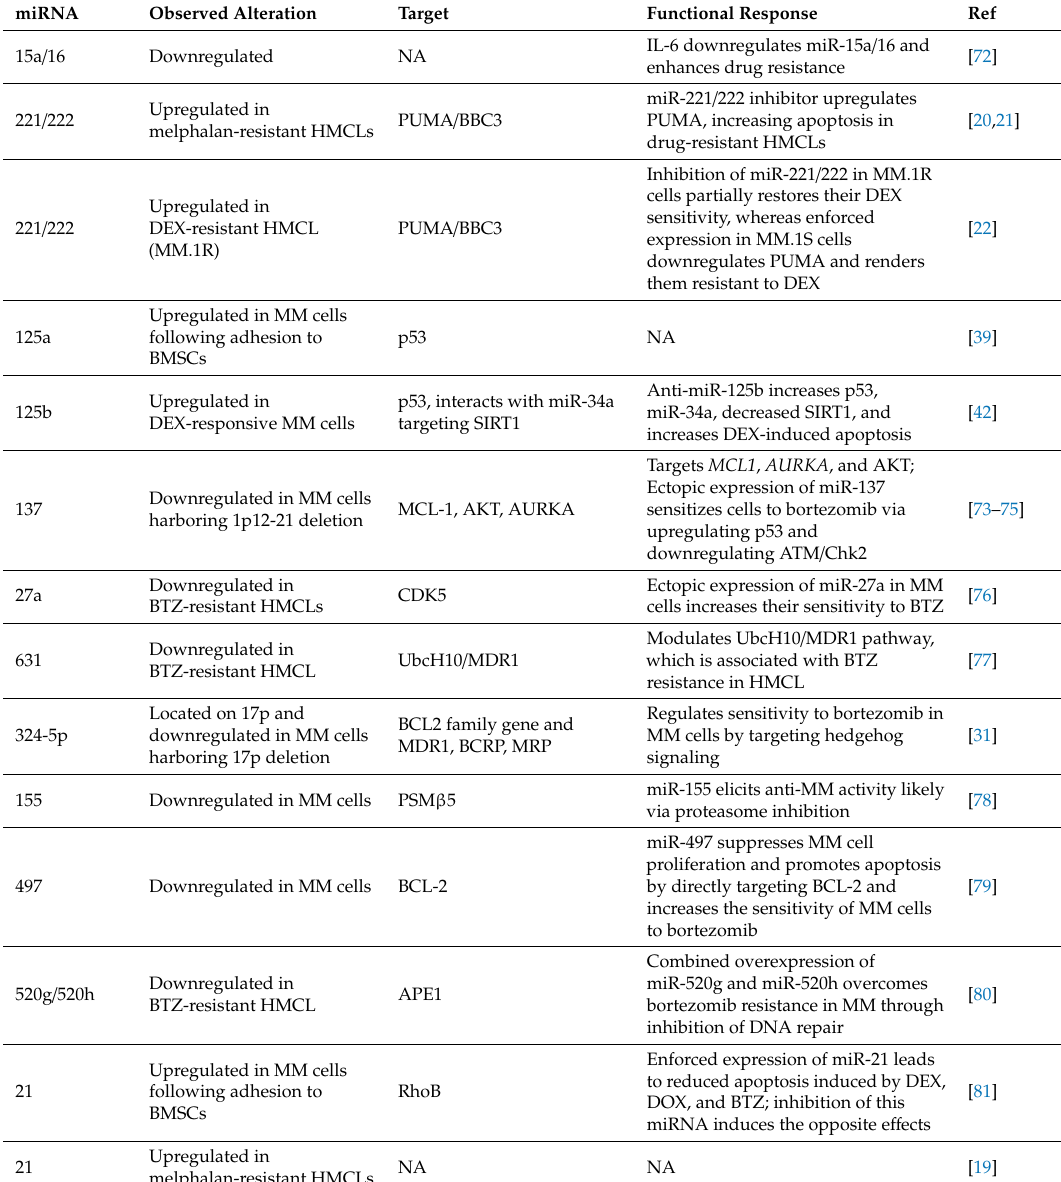
Table 2. miRNAs and their potential role in multiple myeloma (MM) drug